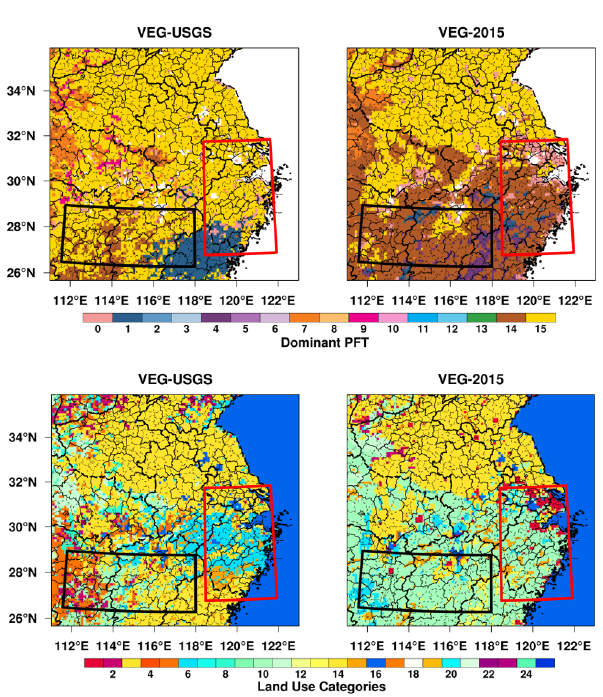
Figure 2. Biogenic emission factor for each land use category in (a) MEGAN v1.0, and (b) for each PFT in MEGAN v3.0. The PFT numbers 0–15 are listed in Table